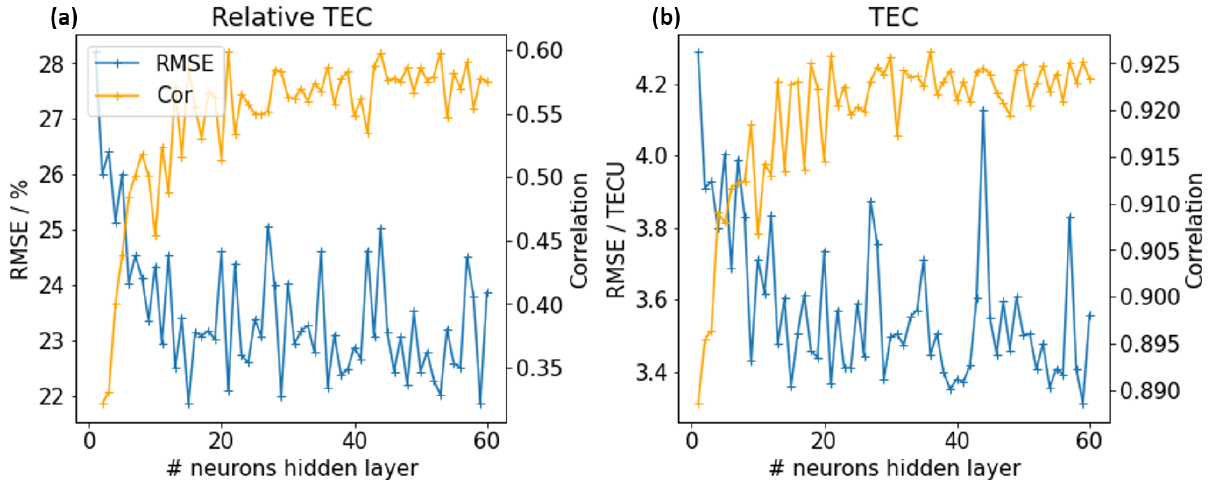
Figure 5. The number (#) of neurons in the hidden layer plotted against the root mean square error (RMSE), shown with the blue line, and the correlation (orange line) for the relative TEC ( a ) as a percentage and the TEC ( b ) in TEC Units (TECU). Table 2. The RMSE and correlation results for the relative TEC and the TEC considering different architectures.